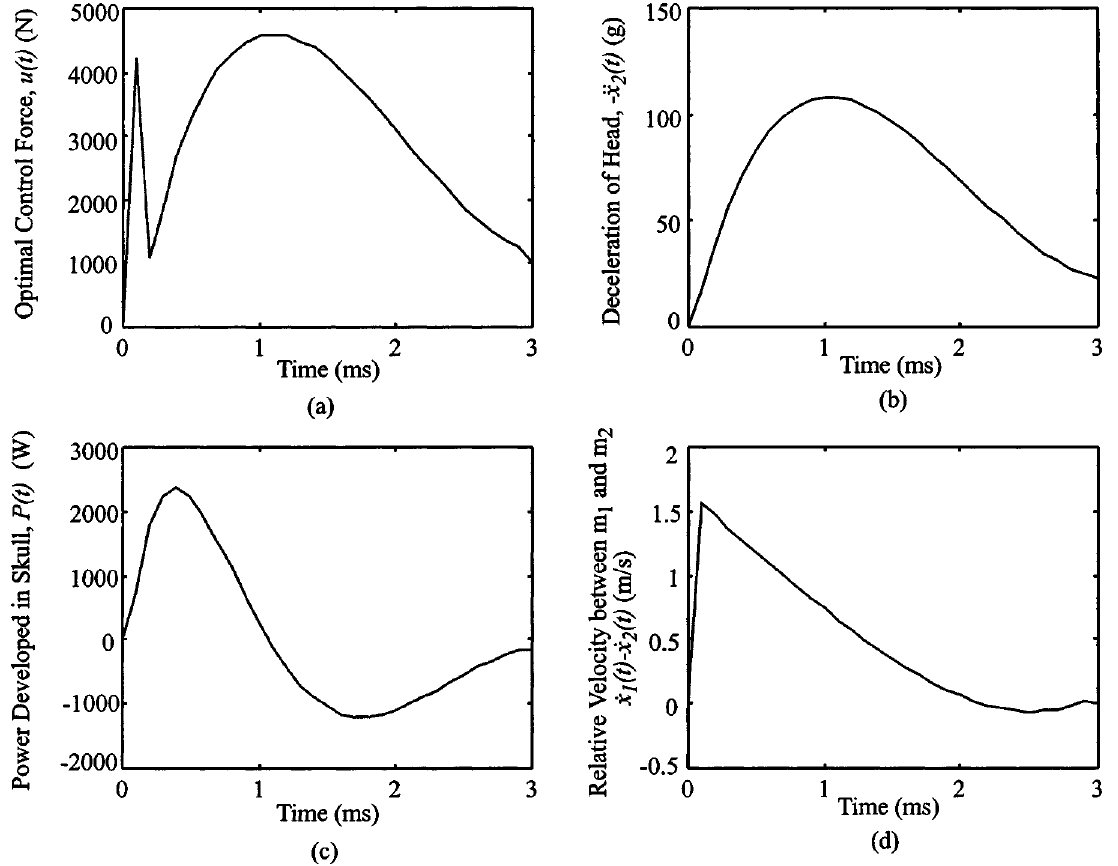
Fig. 16. Time histories of the optimal control force and the system responses. Case 2: Minimization of the energy imparted to the brain, L–R direction, S